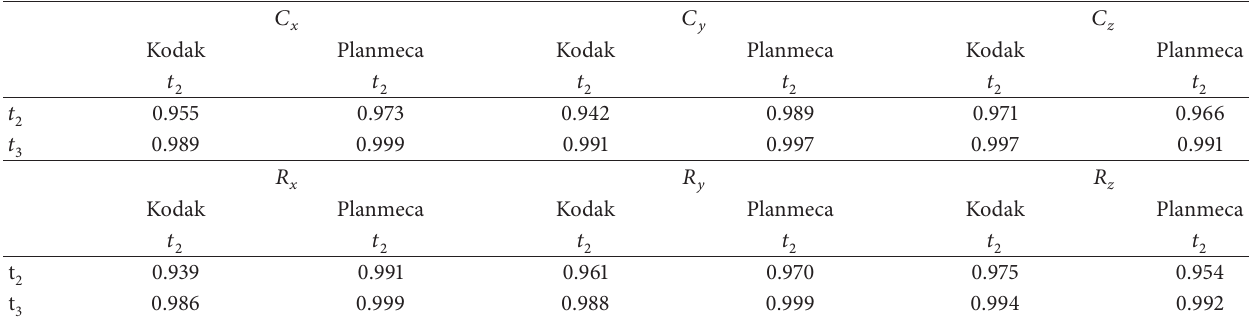
Table 6: Kendall’s 𝑊 values for interrater agreement at 𝑡 2 and 𝑡 3 , clustered by software and KPG single